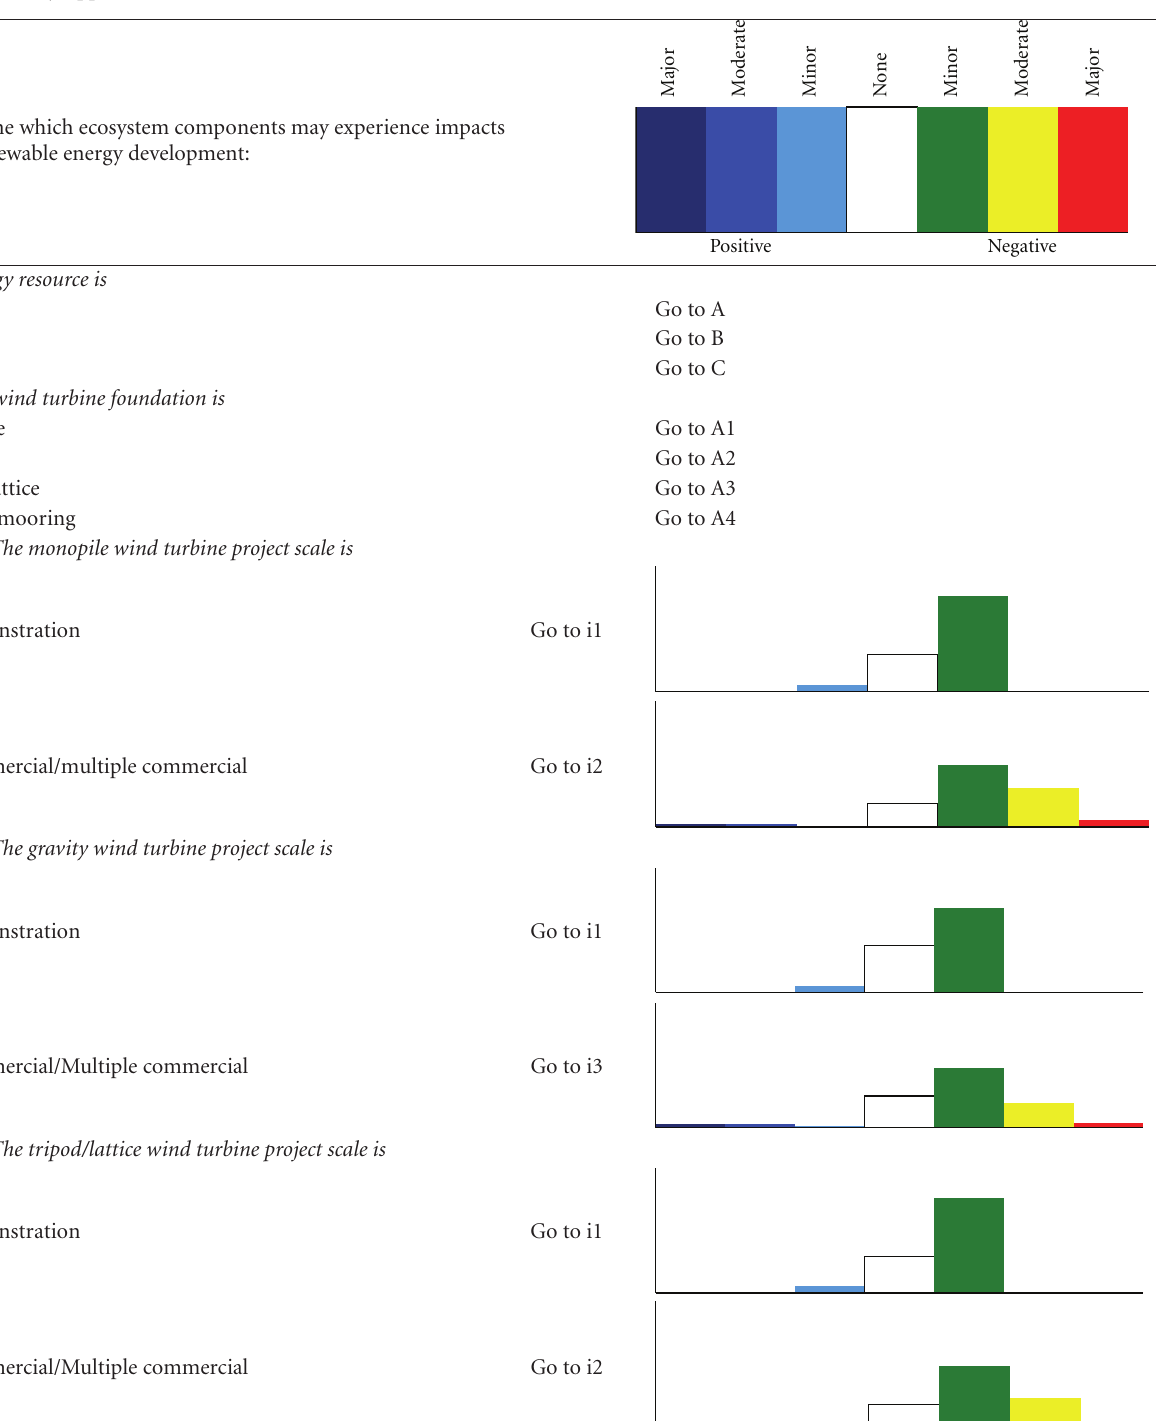
Table 2: The impact decision tree. Each step of the key is followed until an Impact scenario is reached, denoted by “i#”. A bar graph is shown with each Impact scenario displaying the proportion of impacts, color-coded by direction (positive or negative) and magnitude (none, minor, moderate major). Data is derived from the literature review (Supplementary Appendix A) and renewable energy impact matrix (Supplementary Appendix